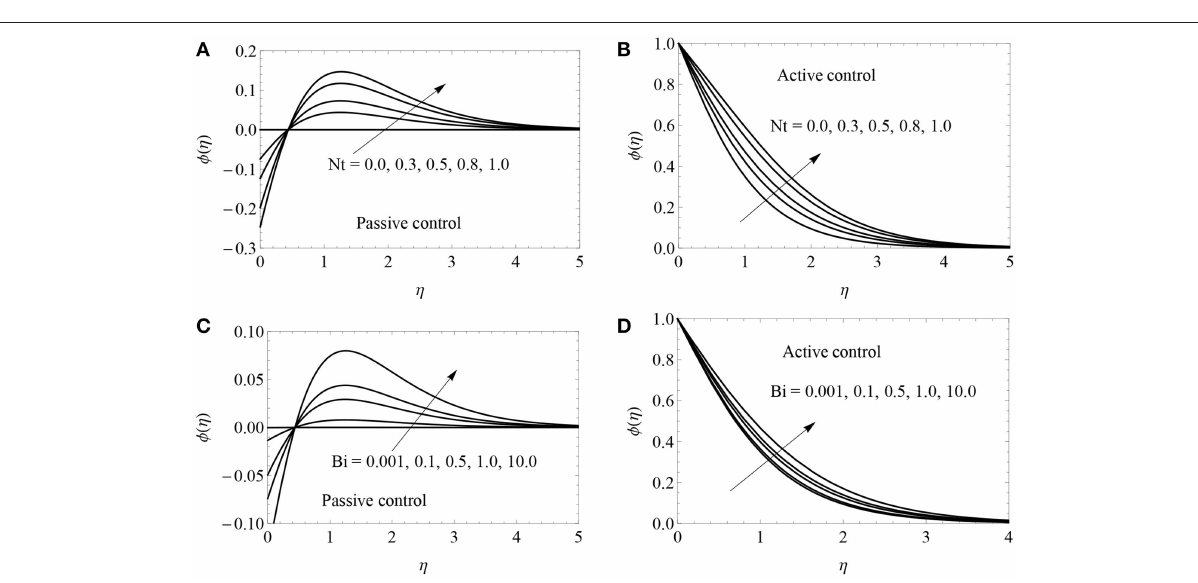
FIGURE 3 | Nanoparticle volume fraction profile of different values of Nt (A,B) and Bi (C,D) for both passive and active cases with K Hg 0.3. = −